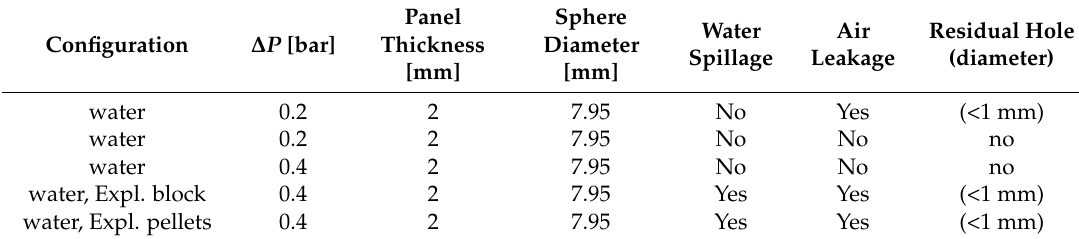
Table 4. Results of ballistic tests with a pressurized tank.